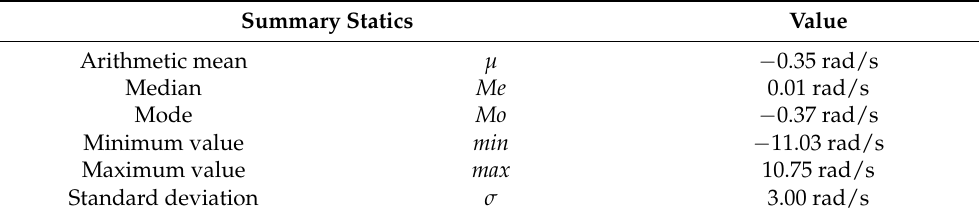
Figure 23. GPI observers signals: ( a ) estimation of disturbances ˆ ϕ , ( b ) output and estimated angular speed, ( c ) estimation error, ( d ) histogram of estimation error, and ( e ) torque load estimation. Table 5. Summary statistics of GPI observer that estimate the